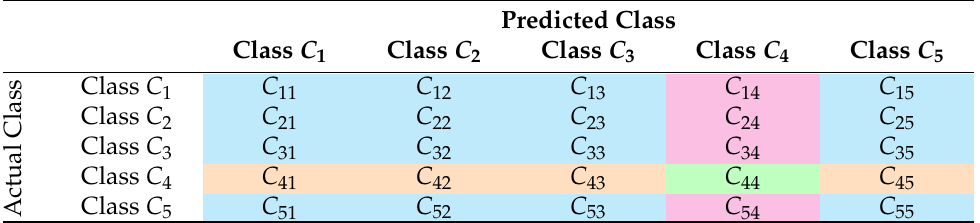
Table 5. Multiclass confusion matrix. The colored cells correspond to the true positive (green), true negatives (cyan), false negatives (orange) and false positives (magenta) associated with the C 4